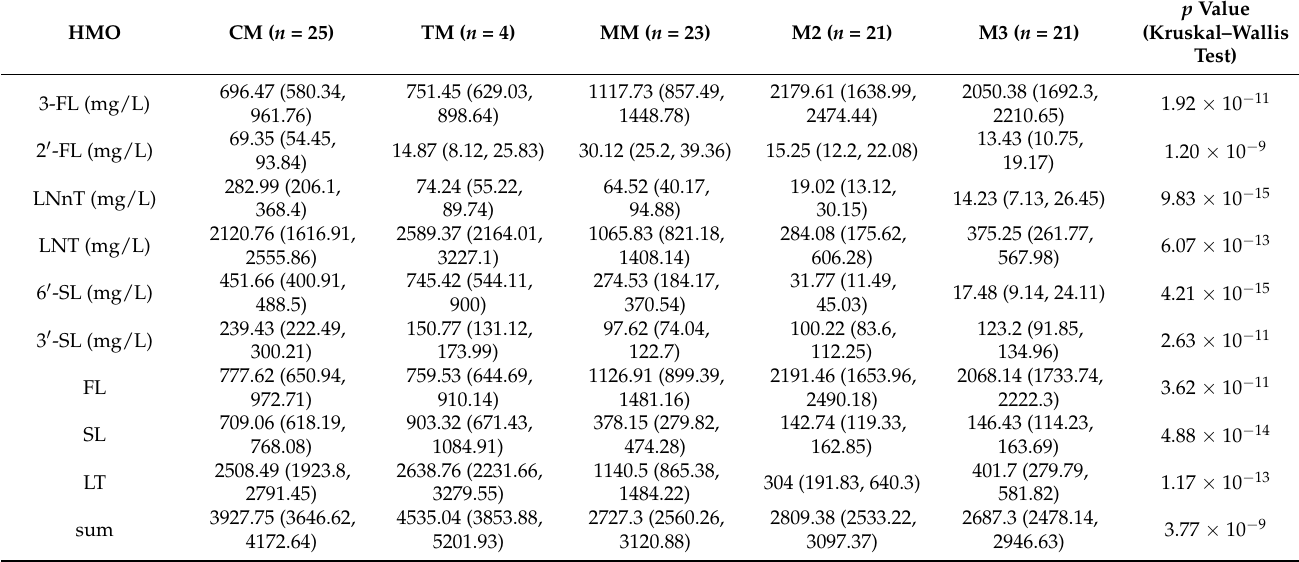
Table 4. The HMOs between different stages in non-secretors ( n = 94).